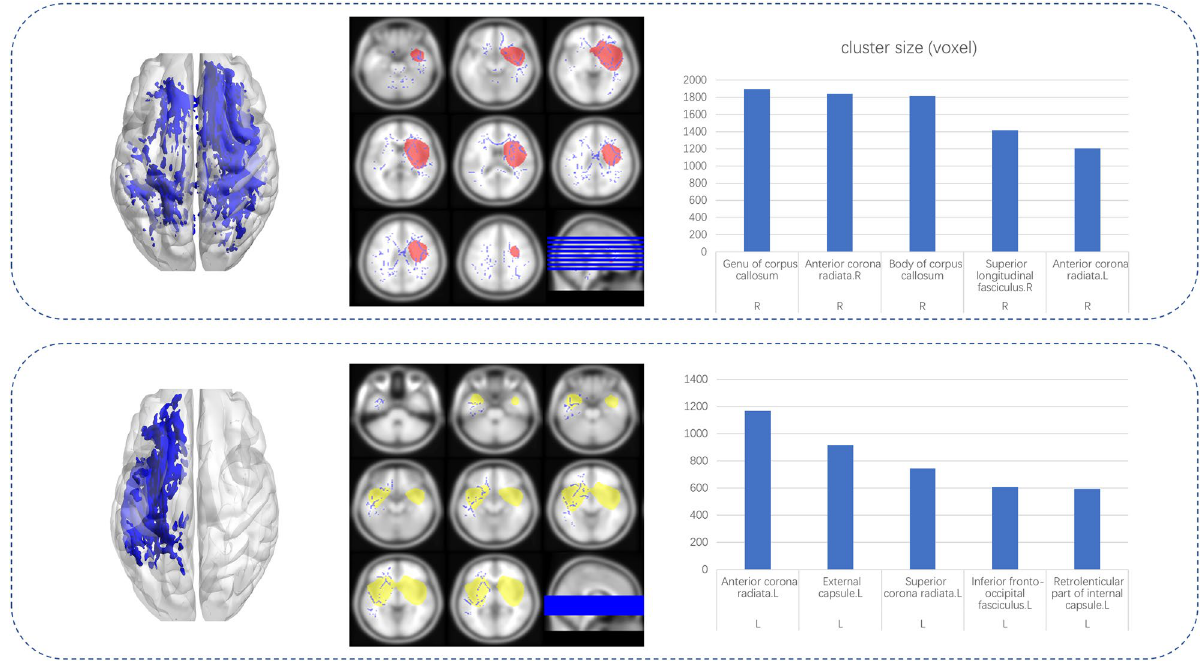
Figure 4. Clusters with significantly lower FA in LIG or RIG compared to the controls, identified by voxel-wise TBSS analysis. A: Left-sided axonal overlapping images of major crossovers (middle), as well as a 3-D rendered image (left). Bar graphs of the most common clusters are shown on the right. B: Right-sided axonal overlapping images of major crossovers (middle), as well as a 3-D rendered image (left). The bar graphs of the most common clusters are shown on the right.